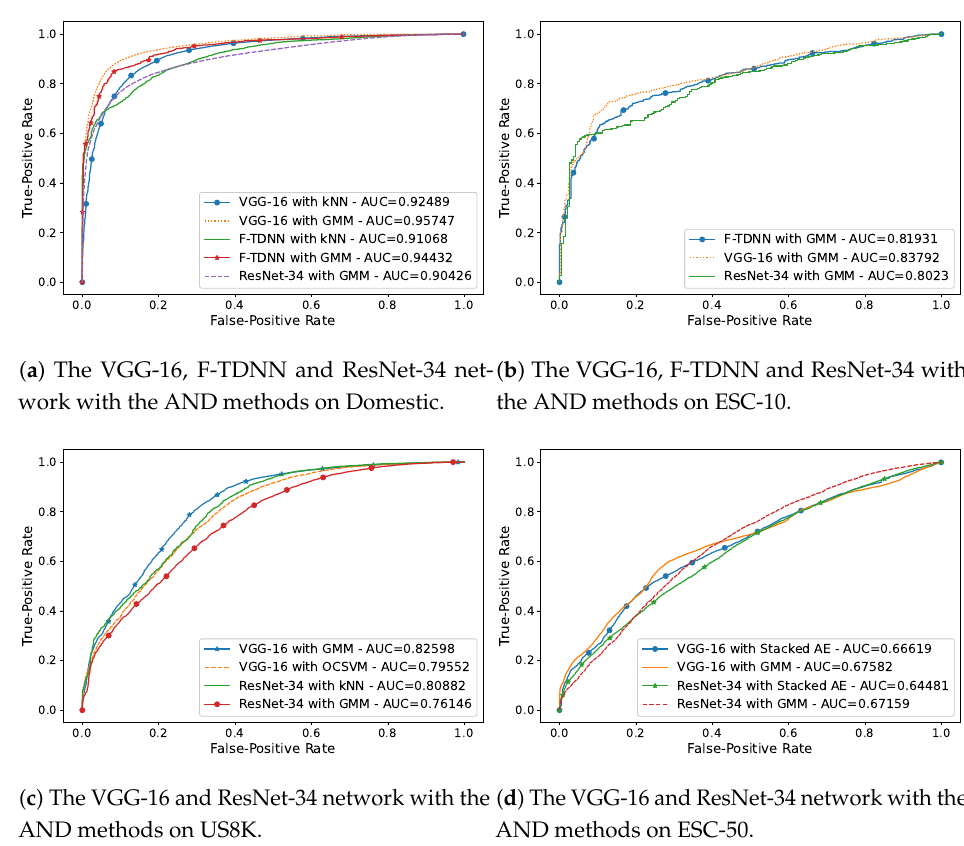
Figure 3. The AUC curves of the best performances of the AND methods in the most complicated AND scenario in which only one event is unknown on the datasets: ( a ) Domestic, ( b ) ESC-10, ( c ) US8K, and ( d )